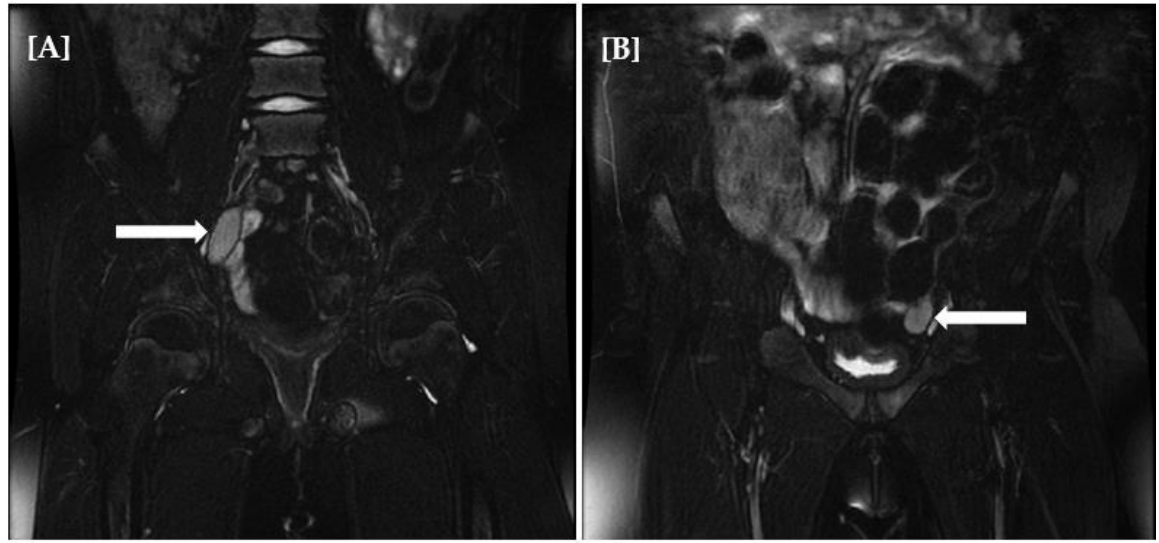
Figure 2. Magnetic resonance imaging (MRI) of abdomen and pelvis minor showing presence of gonads (right ( A ), left ( B )) with the absence of the structures derived from the Müllerian ducts.